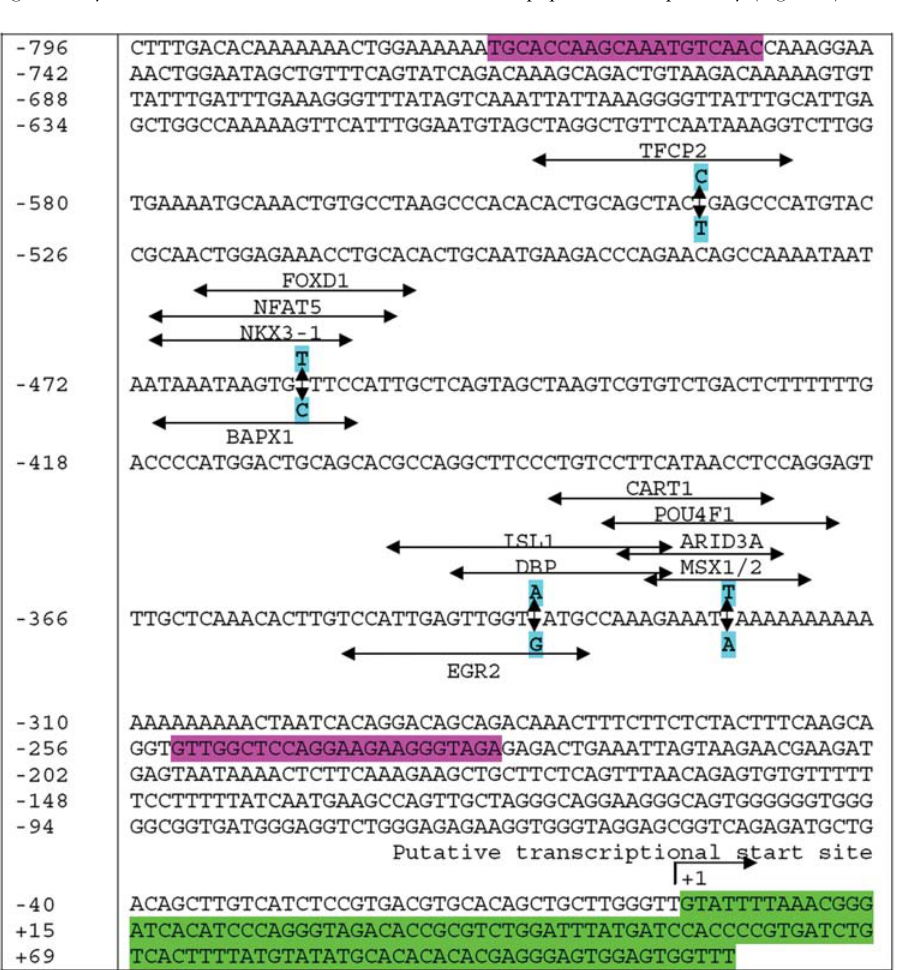
Figure 3. Nucleotide sequence of the proximal promoter region of the bovine UCN3 gene. Primer and partial non-coding exon 1 sequences are shadowed by pink and bright green color, respectively. The putative transcription start site is numbered as + 1. Four polymorphic sites that were associated with SFD are bold and shadowed by turquoise color. Potential transcription regulatory binding sites for TFCP2, NFAT5, NKX3-1, FOXD1, ISL1, DBP, CART1, POU4F1, ARID3A and MSX1/MSX2 are associated with haplotype CTAT , while only binding sites for BAPX1 and EGR2 are linked to haplotype TCGA .